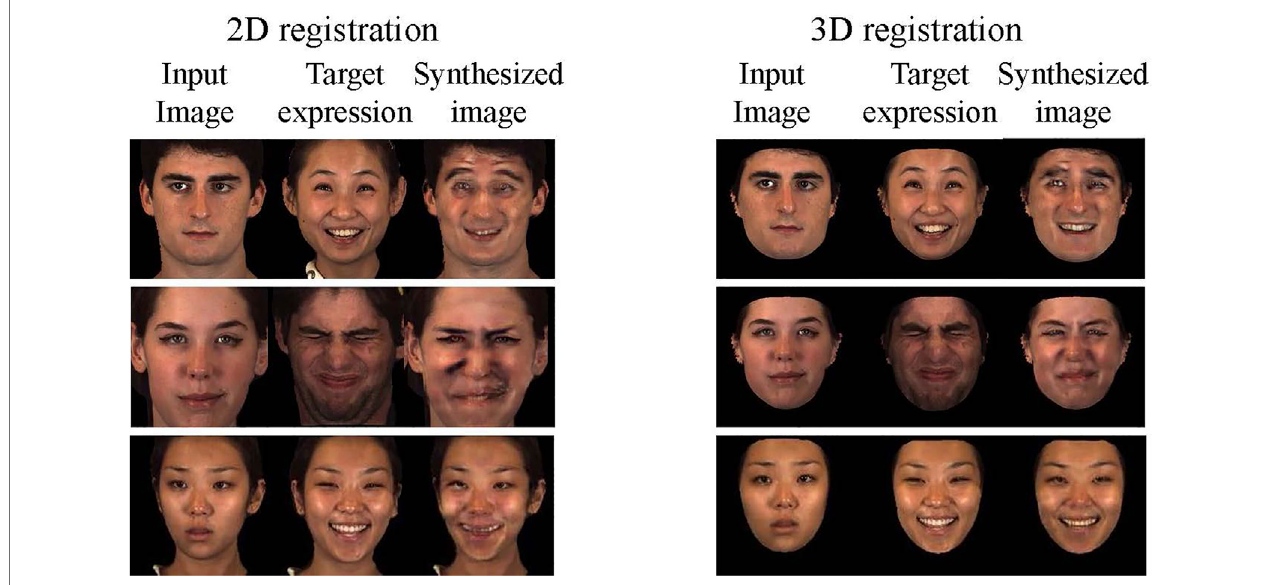
FIGURE 2 | Examples of 2D and 3D normalization. Note the higher image quality when 3D normalization was used.